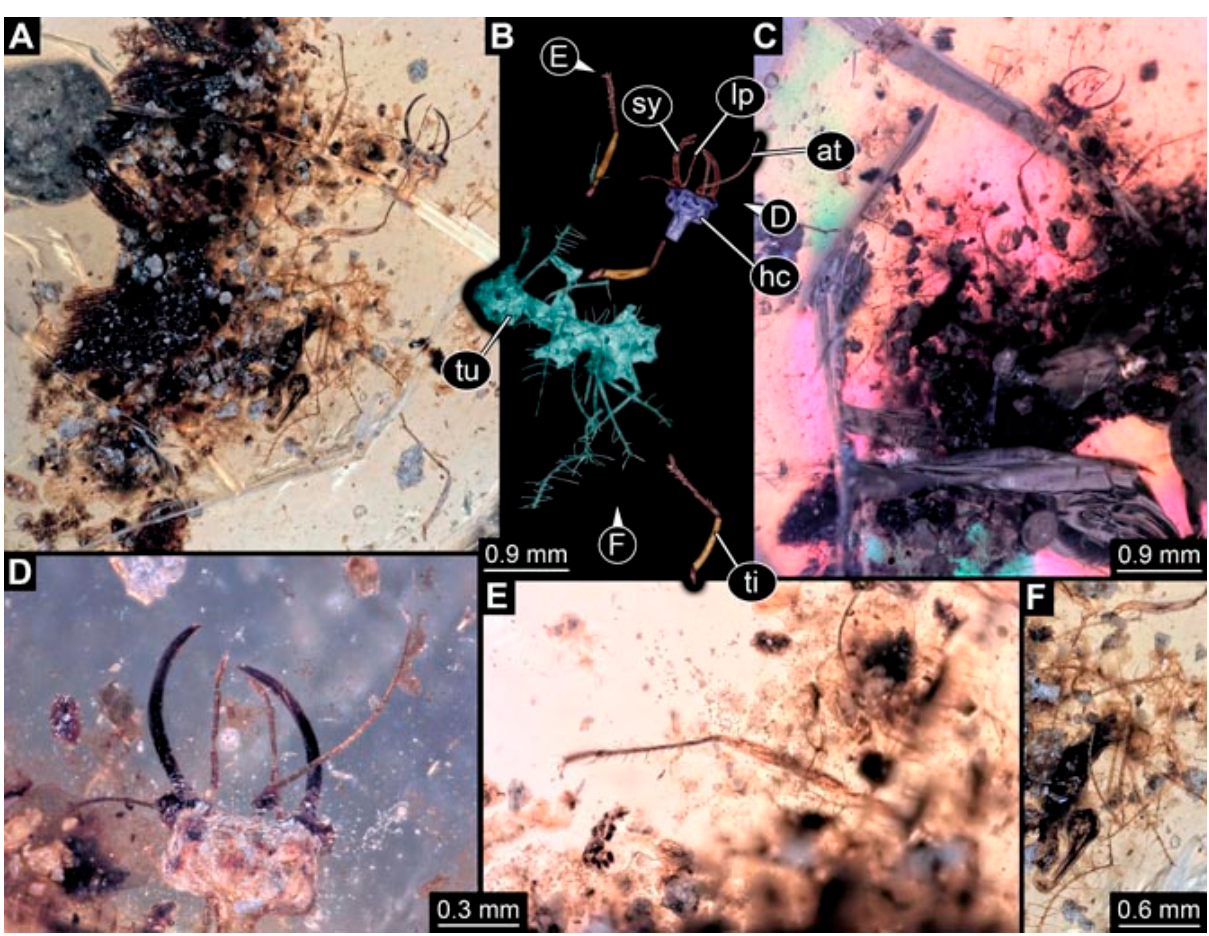
Figure 42. Specimen 4872 (PED 1322); Myanmar amber. ( A ) Dorsal view. ( B ) Dorsal view, colour- marked. ( C ) Ventral view. ( D ) Close-up of head capsule in dorsal view. ( E ) Close-up of trunk appendages. ( F ) Close-up of protrusions in dorsal view. Abbreviations: at = antenna; hc = head capsule; lp = labial palp; sy = stylet; ti = tibia; tu = trunk.